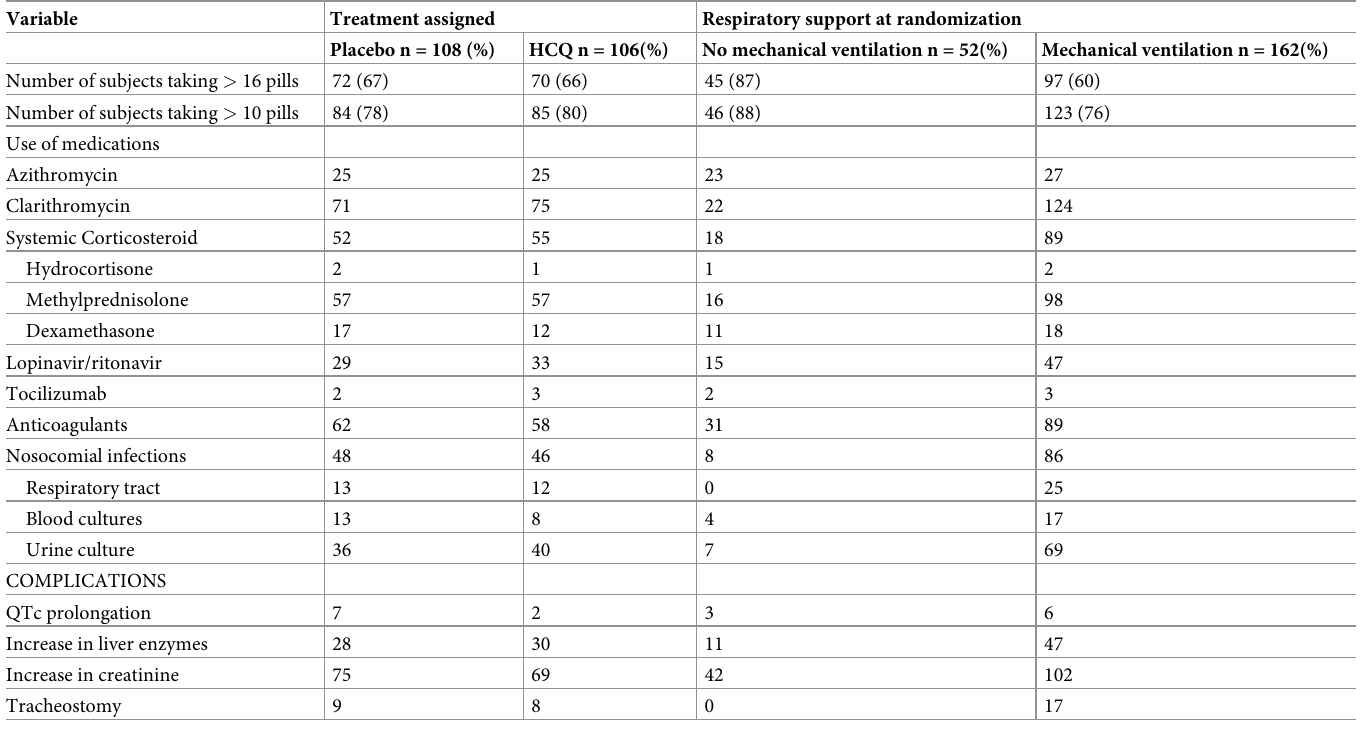
Table 2. Coexisting medications and adverse